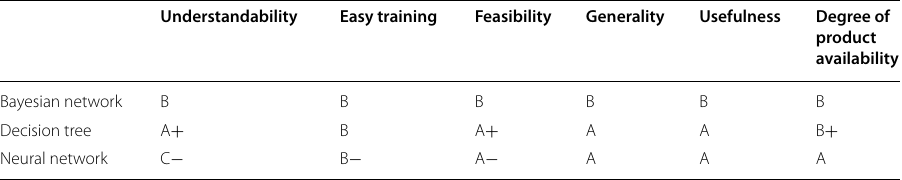
Table 1 Comparison of several common classification algorithms